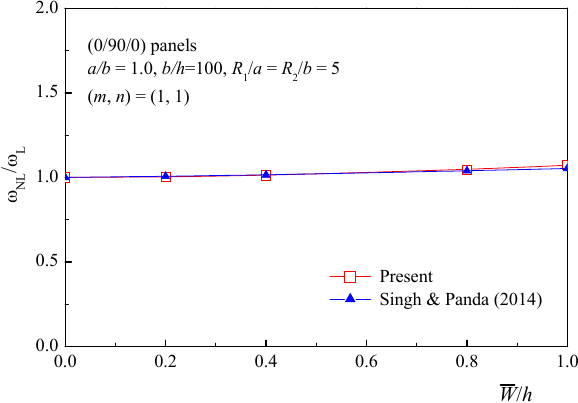
formation theory. The panel is of movable in-plane bound- ary condition. The geometric parameters and the material properties used in the computation study are: a / b = 1, b/h = 100, R 1 / a = 5, R 2 / b = 5, E 11 = 40 E 22 , G 23 = 0.5 E 22 , G 12 = G 13 = 0.6 E 22 , ν 12 = 0.25. Only the vibration mode of ( m , n ) = (1, 1) is considered. The three comparison stud- ies have shown that good agreement is achieved between the results from the present solution method and from ex- isting research work in the open literature. Tables 5-7 and Figures 3-7 present the numerical re- GRC laminated panels with h = 2 mm, a / b = 1.0, b / h = 10